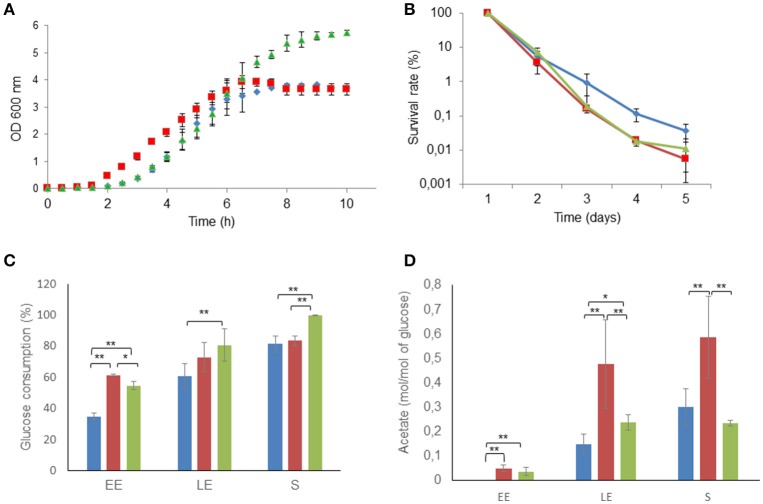
Altered growth and long-term survival of ΔmsrAB mutant cells and complemented ΔmsrAB/pHT304msrAB cells. (A) Growth curves of WT (blue), ΔmsrAB (red) and ΔmsrAB/pHT304msrAB (green) cells in pH-regulated batch cultures under aerobiosis. (B) Long-term survival of WT (blue), ΔmsrAB (red) and ΔmsrAB/pHT304msrAB (green) cells after growth under aerobiosis. (C) Glucose consumption of WT (blue), ΔmsrAB (red) and ΔmsrAB/pHT304msrAB (green) cells. (D) Acetate production of WT (blue), ΔmsrAB (red) and ΔmsrAB/pHT304msrAB (green) cells. Significant differences are indicated with one (p < 0.05) or two (p < 0.01) asterisks.